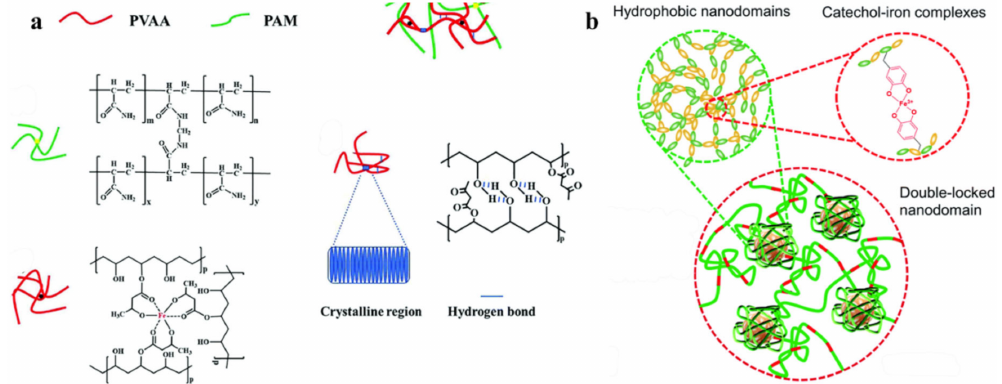
Figure 52. ( a ) Physically cross-linked H-bonds and crystals of aggregated polyvinyl alcohol acetoacetate (PVAA) domains in Fe 3 + / PVAA-PAM hydrogels. Reproduced from [224] with permission from The Royal Society of Chemistry. ( b ) Rigid double-locked hydrophobic nanodomains are composed of multiple iron–catechol complexes and are surrounded by a flexible polymer matrix (PEG). Reproduced from [225] with permission from The Royal Society of